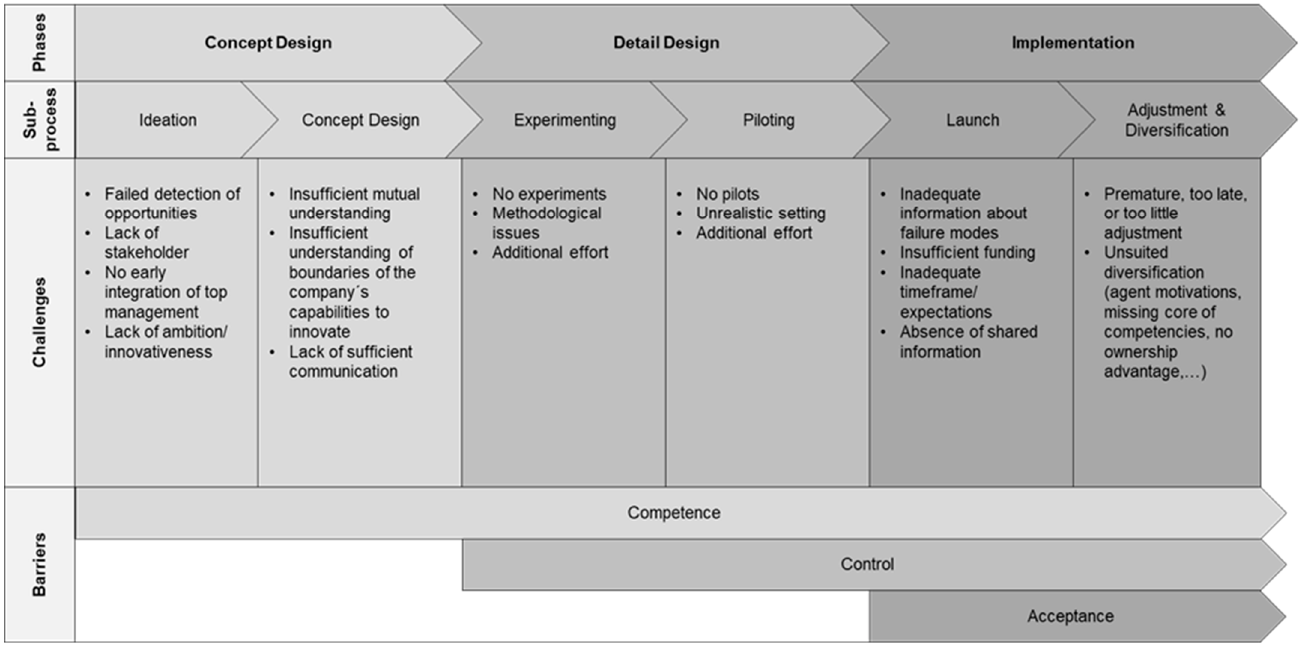
Figure 9. Holistic digital technology implementation process for construction companies which addresses current barriers (adopted from the Cambridge Business Model Innovation Process by Geissdoerfer et al. [69]).